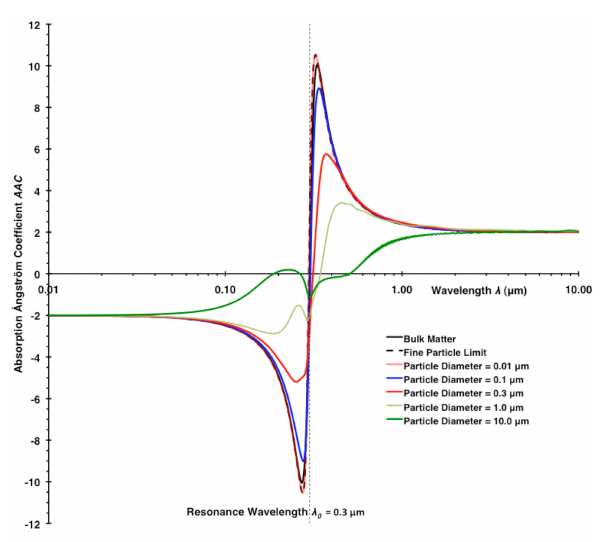
Fig. 8. Damped simple harmonic oscillator model wavelength de- pendence of the absorption ˚Angstr¨om coefficient (AAC) for bulk matter (Eqs. 4b, c and Fig. 3), fine particles (Eq. 12), and spherical particles with particle diameter ranging from 0.01µm to 10µm from Mie theory calculations using the bulk refractive index (Eqs. 4a,